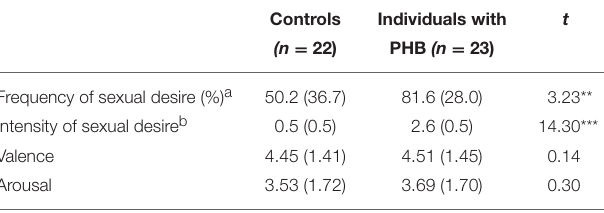
TABLE 2 | Psychological assessment results. TABLE 3 | Brain regions identified by the group analysis.